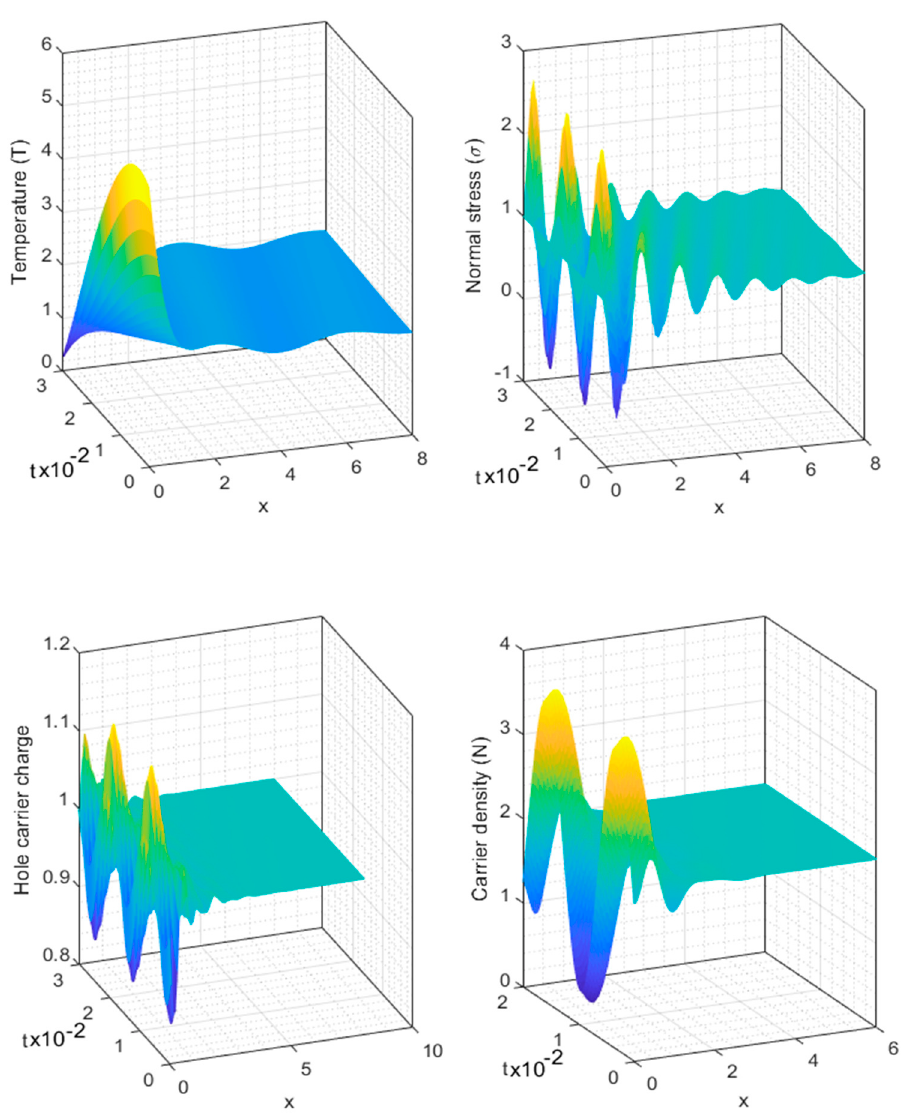
Figure 4. According to the DPL model and under the influence of Hall current, the principal fields in 3D plots for non-local Si material vary with variations in time and distance. 3D plots for non-local Si material vary with variations in time and